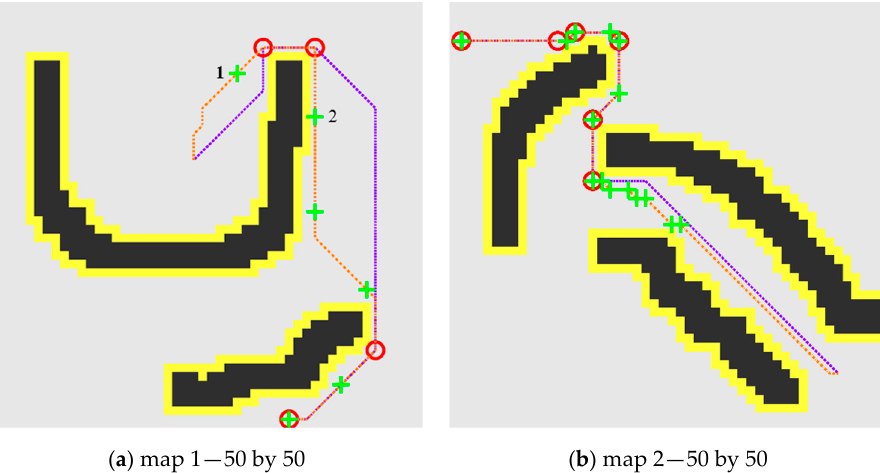
Figure 7. ( a – b ) Orange lines denote paths planned by A*, and purple lines denote paths generated by the path planner in JPS-IA3C. Small red circles denote subgoals planned by JPS-IA3C. Yellow regions denote warning areas. ( a ) A* find subgoals (i.e., green crosses) by sampling optimal paths at fixed intervals. ( b ) A* plans subgoals (i.e., green crosses) through taking the inflection points of optimal paths.